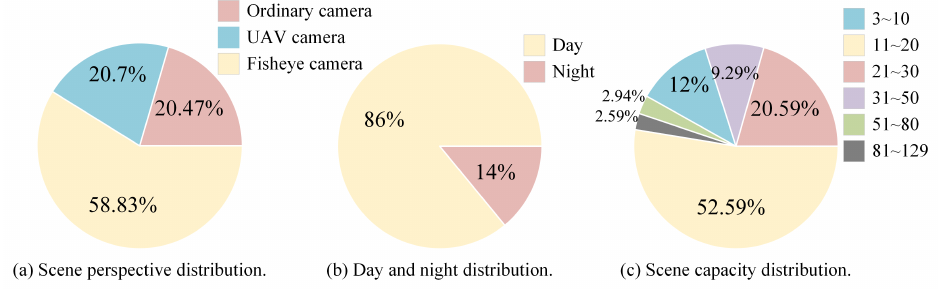
Figure 5. The data distribution of the above